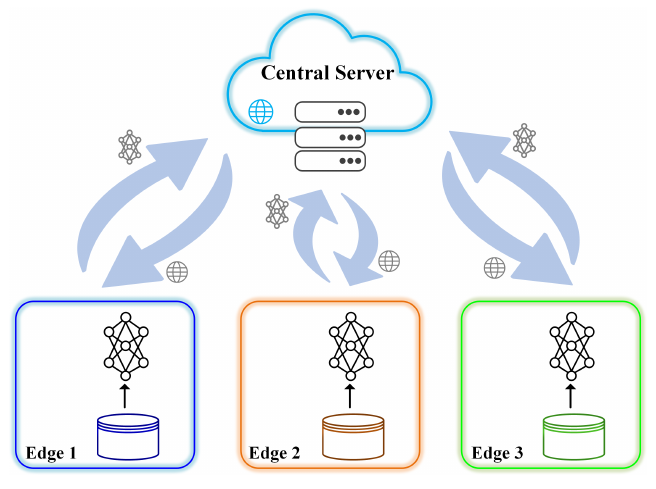
Figure 2. Federated learning